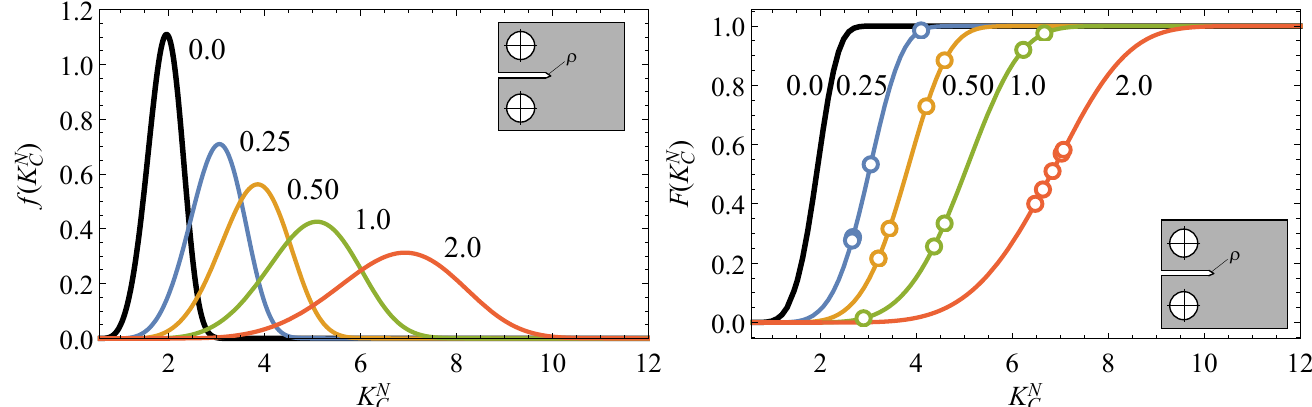
Figure 9. Theoretical predictions of the pdf and cdf of the apparent fracture toughness for different notch radii conditions and the experimental values obtained from EPOLAM